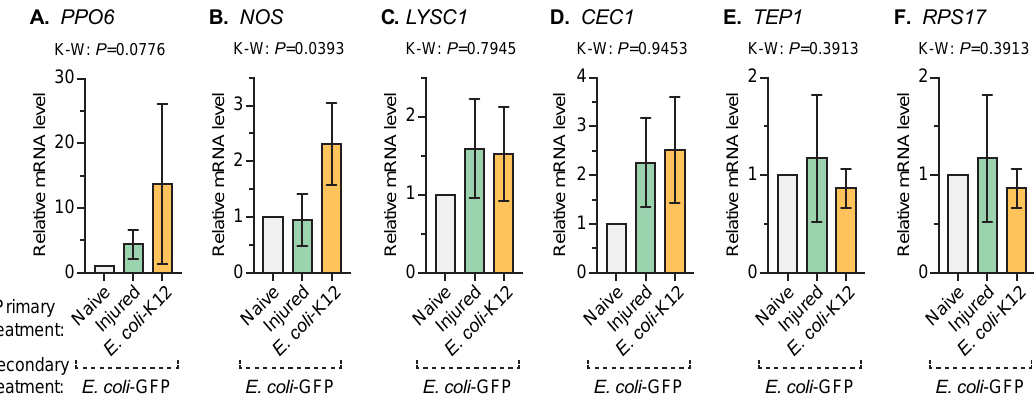
Figure 5. Immune gene expression after secondary treatment. Five days after the primary treatment of naïve, injury, or infection with E. coli -K12, all the mosquitoes were infected with E. coli -GFP and 1 day later the relative expressions of PPO6 ( A ), NOS ( B ), LYSC1 ( C ), CEC1 ( D ), TEP1 ( E ), and RPS17 ( F ) were measured by RT-PCR using RPS7 as the reference. Column heights mark the mean and whiskers denote the SEM.